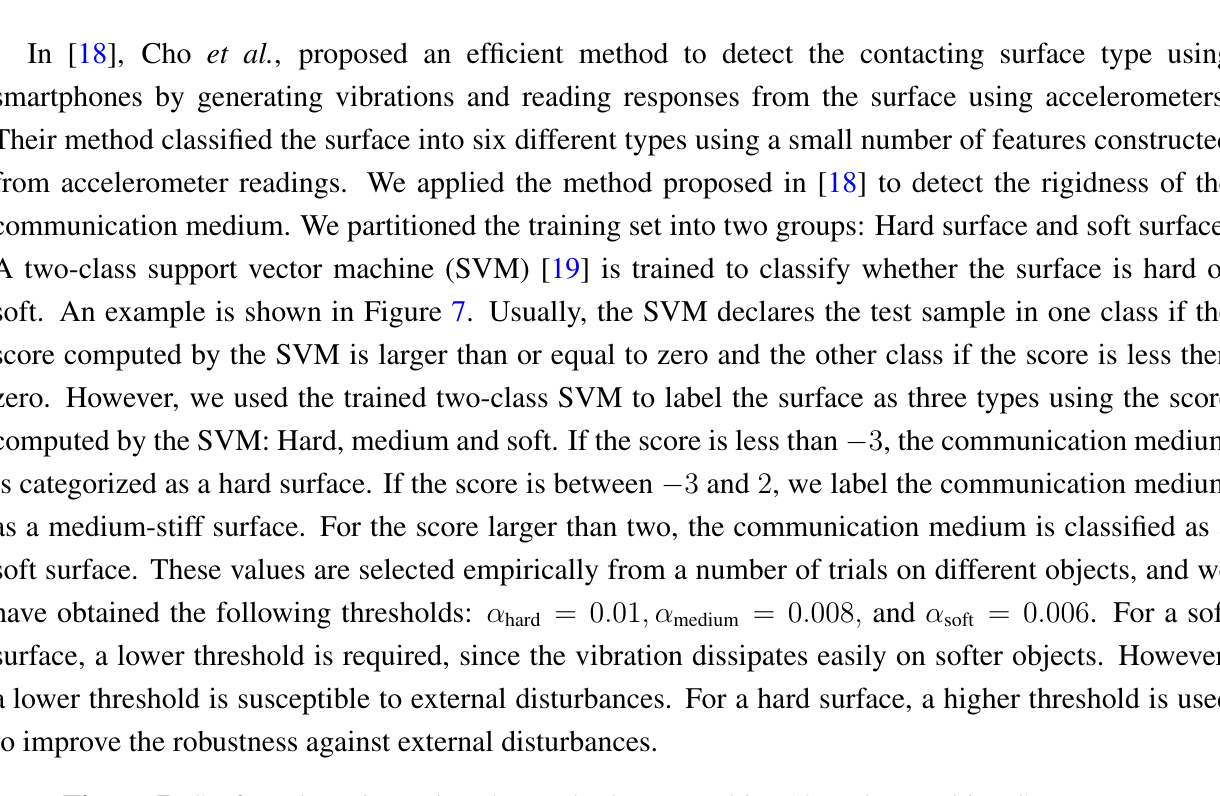
Figure 7. Surface detection using the method proposed in [18]. The resulting SVM scores are displayed. ( a ) Hard surface detection; ( b ) soft surface